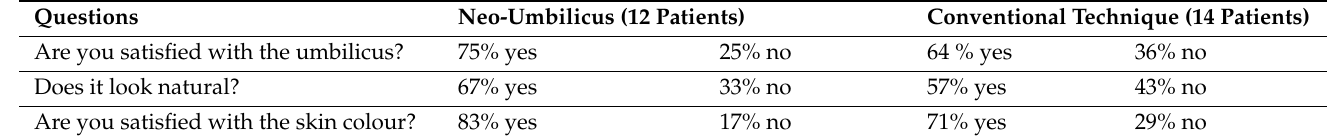
Table 1. Results of the patients’ questionnaire. The neo-umbilicus received better ratings, but this was not significant.